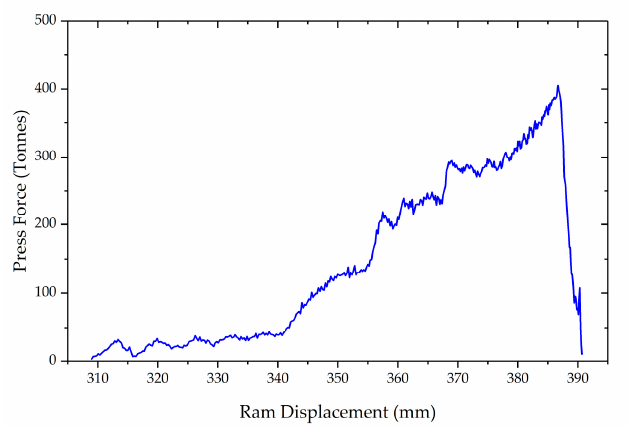
Figure 7. Example of the recorded press force against the displacement of the press for Trial 1.